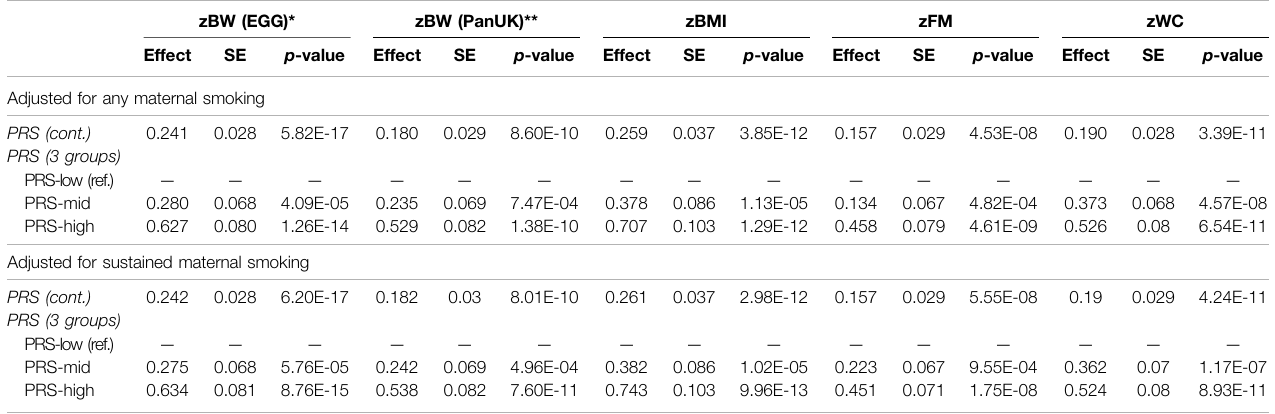
TABLE 3 | Association of the PRSs with phenotypic traits, adjusted for maternal smoking during pregnancy and covariates. zBW (EGG)*